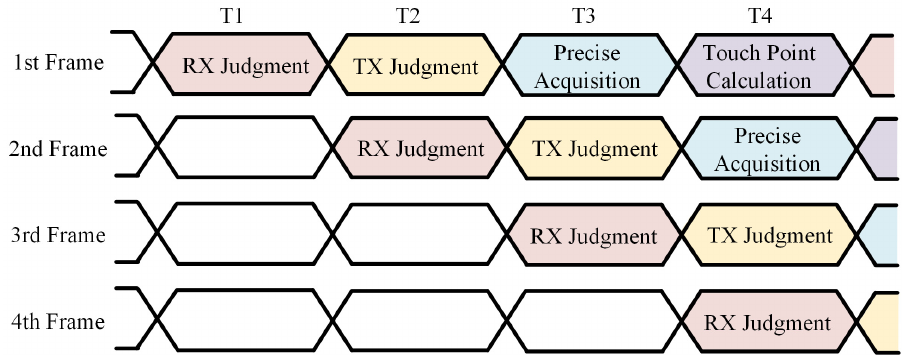
Figure 3. The operation sequence diagram of the proposed low-computing-complexity touch point detection method.